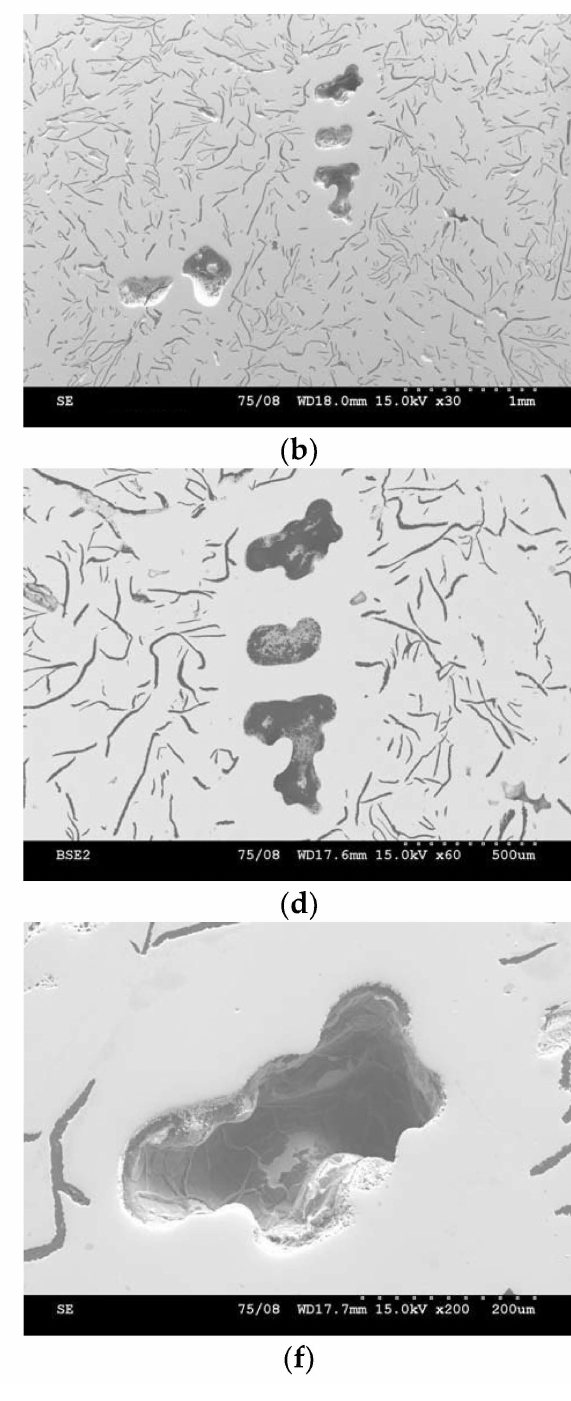
Figure 8. Revealed porosity on surface of lathe bed casting—single void at magnifications of ( a ) 50 × , ( c ) 100 × , and ( e ) 350 × , as well as their grouping at magnifications of ( b ) 30 × , ( d ) 60 × , and ( f ) 200 ×